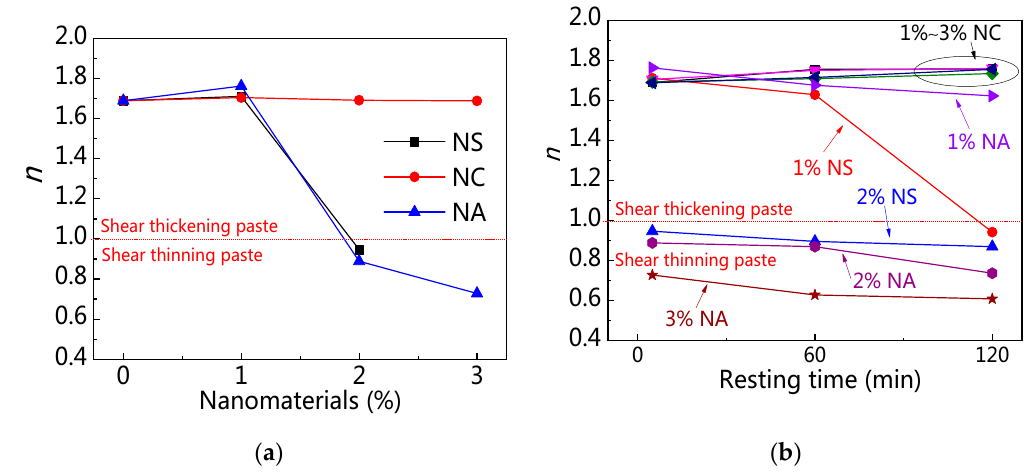
Figure 32. Influence of nanomaterials and resting time on rheological properties: ( a ) nanomaterials content vs. n ; ( b ) resting time vs. n.